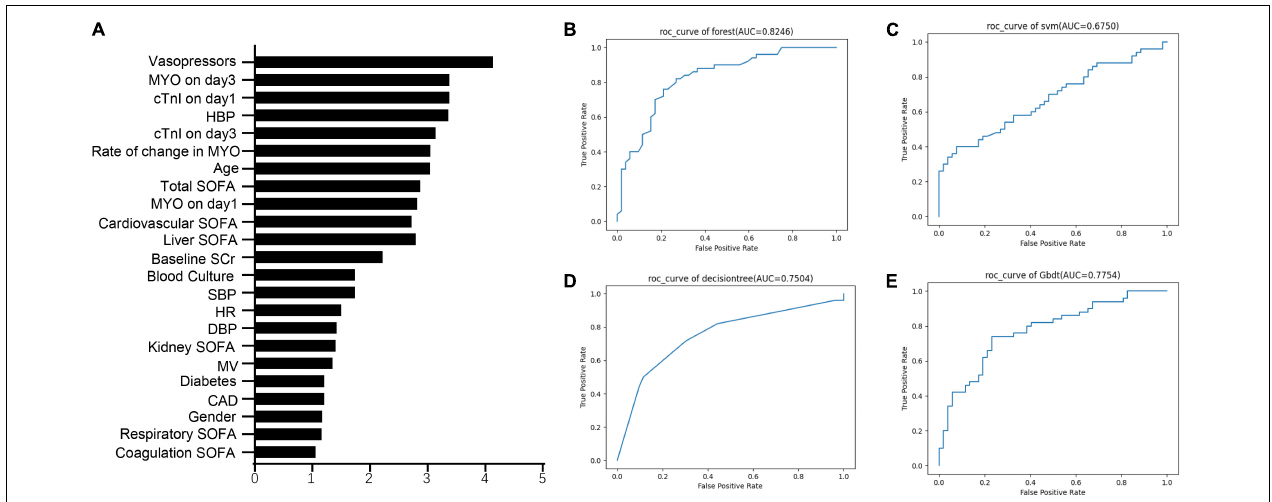
FIGURE 7 | The feature importance and the ROC curves of machine learning models. (A) The feature ranking analysis produced by Random Forest. (B) ROC curves of Random Forest. (C) ROC curves of support vector machine (SVM). (D) ROC curves of decision tree. (E) ROC curves of gradient boosted decision tree (GBDT).